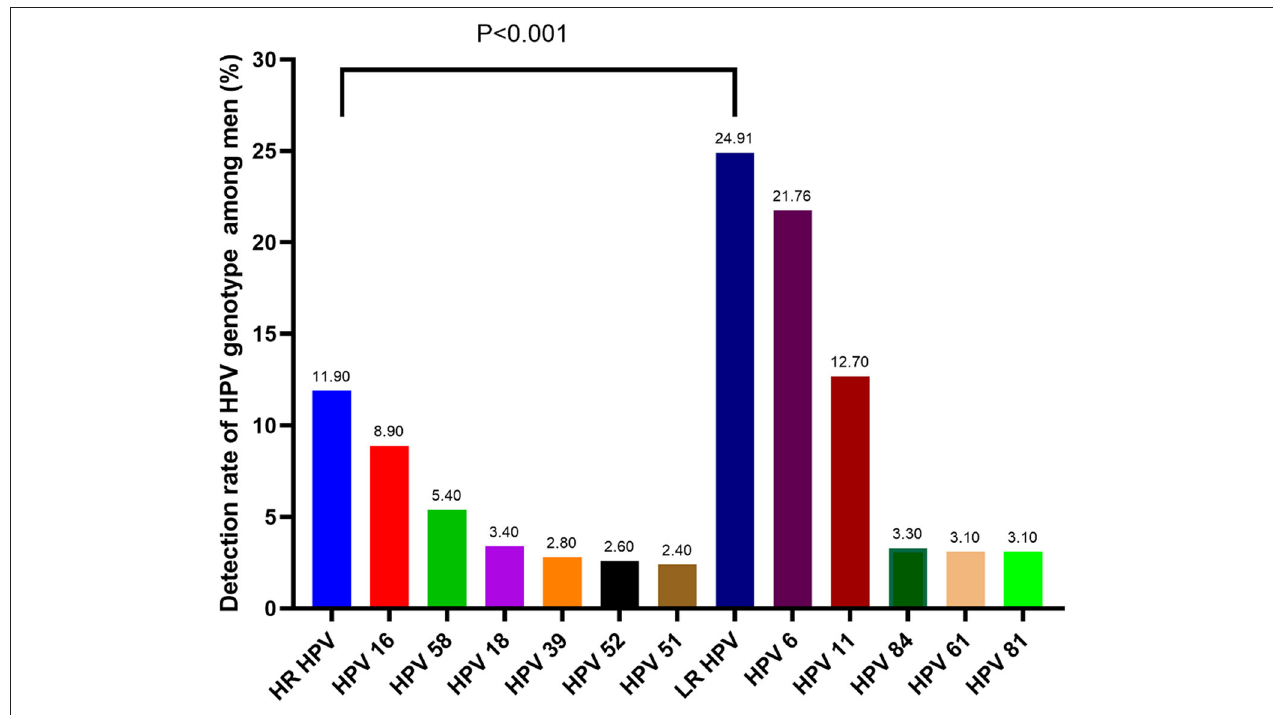
FIGURE 1 | The most common HPV genotype among men ( p < 0.001, HR-HPV vs. LR-HPV).